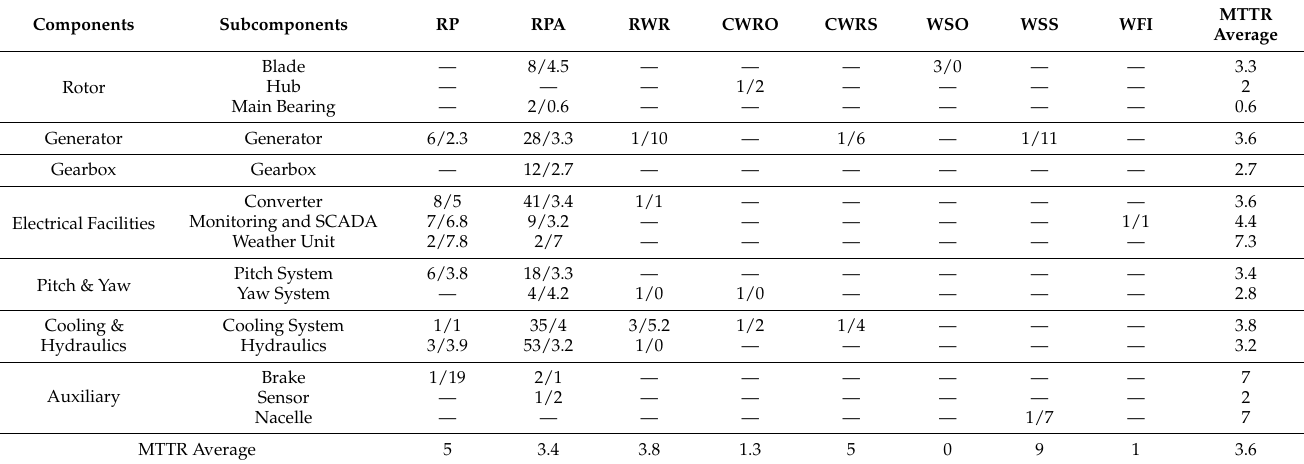
Table A2. The MTTRs of components by maintenance